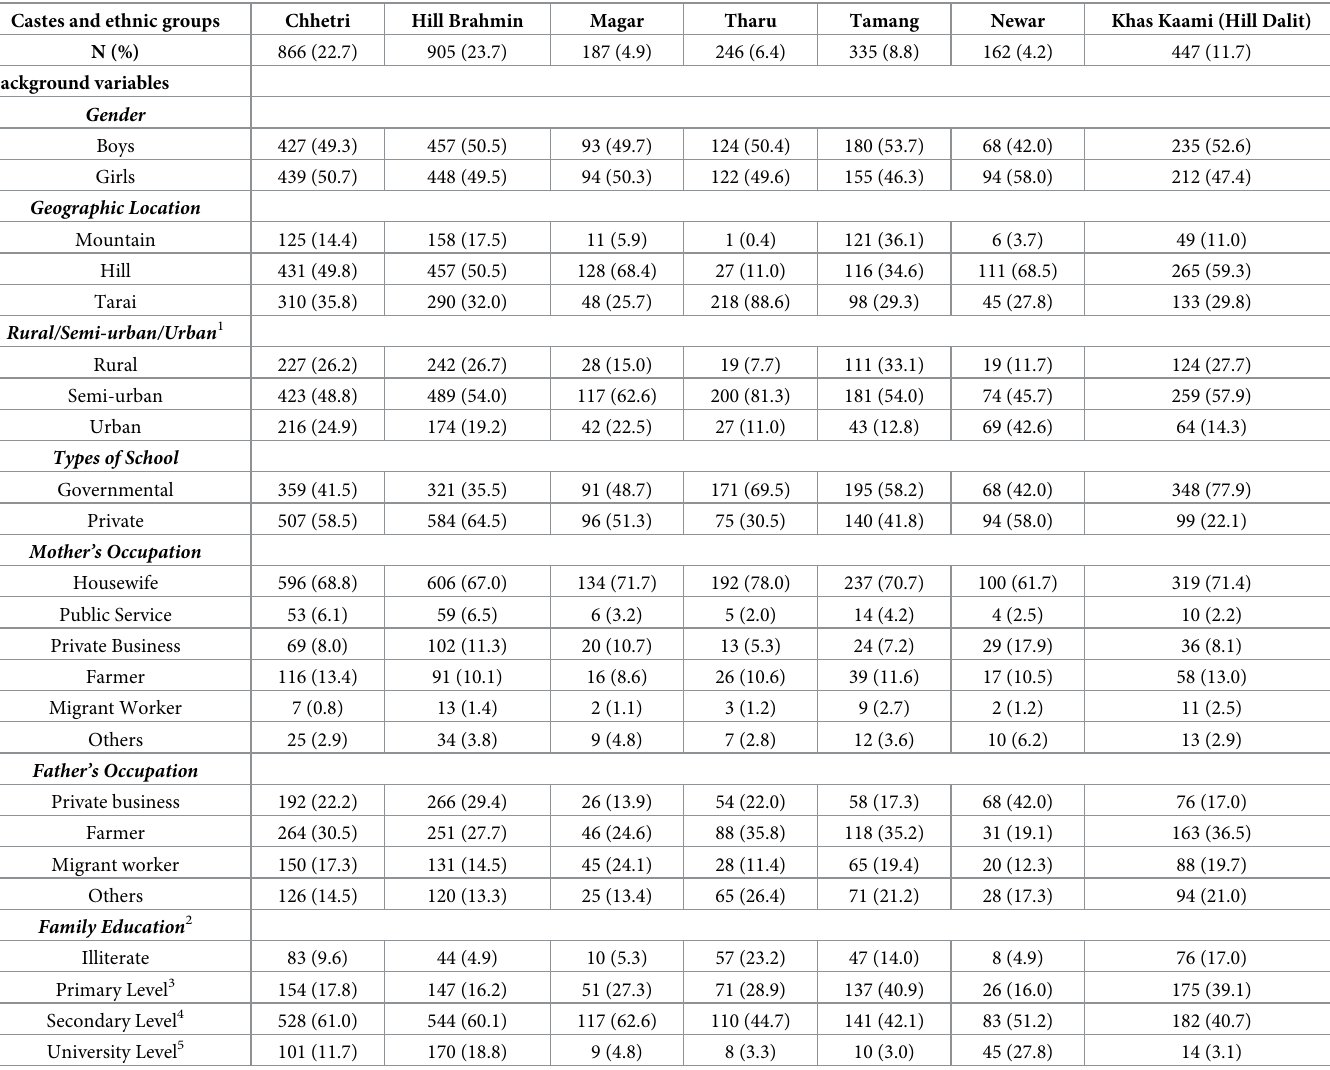
Table 1. Distribution of selected demographic variables for the seven largest castes and ethnic